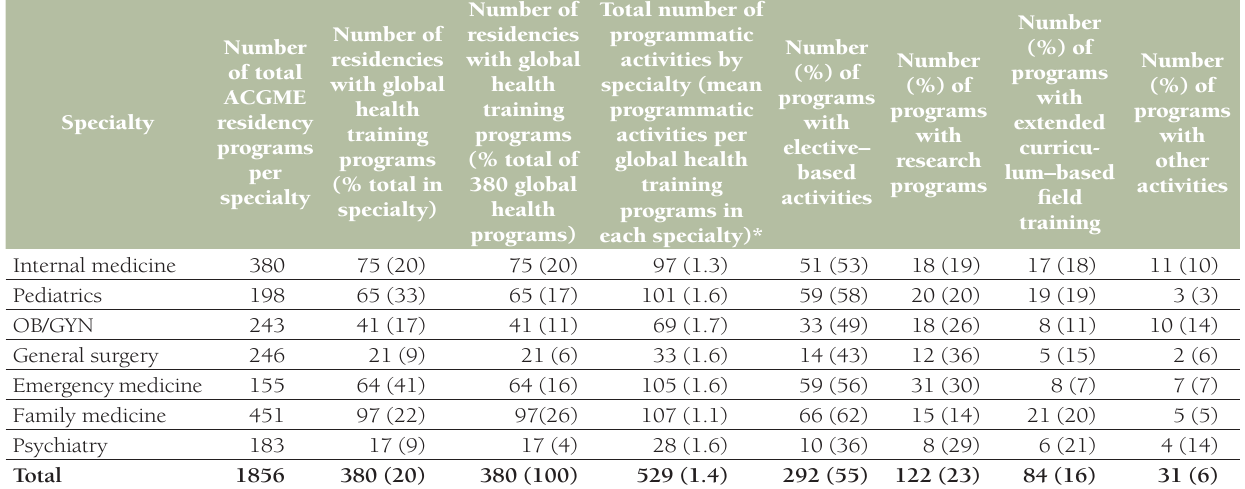
Table 1. Number of global health training programs and programmatic activities per clinical specialty